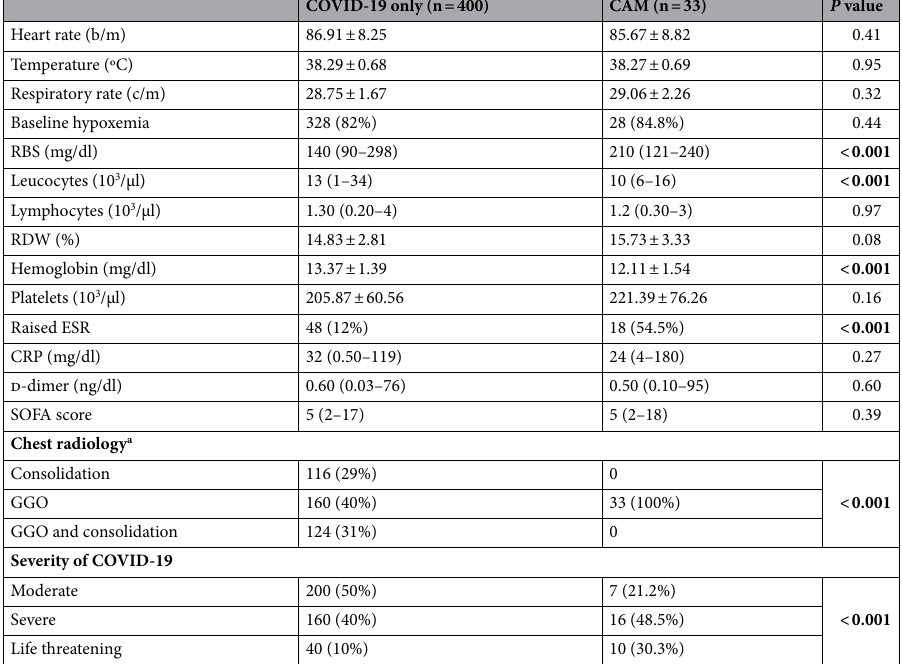
Table 2. Clinical, laboratory and radiological data among enrolled patients. Data expressed as frequency (percentage), mean (SD), median (range) as appropriate. P value was significant if < 0.05. Nominal data was compared by Chi-square test while all continuous data was compared by Student t test with exception of RBS, leucocytes, lymphocytes, CRP, D-dimer and SOFA were compared Mann Whitney test. RBS: random blood sugar; RDW: red cell distribution width; ESR: erythrocyte sedimentation rate; CRP: C-reactive protein; GGO: ground glass opacity; SOFA: sequential organ failure assessment; COVID-19: coronavirus disease 2019. RBS: random blood sugar. Significant values are given in bold. a Included chest computed tomography and plain radiograph.